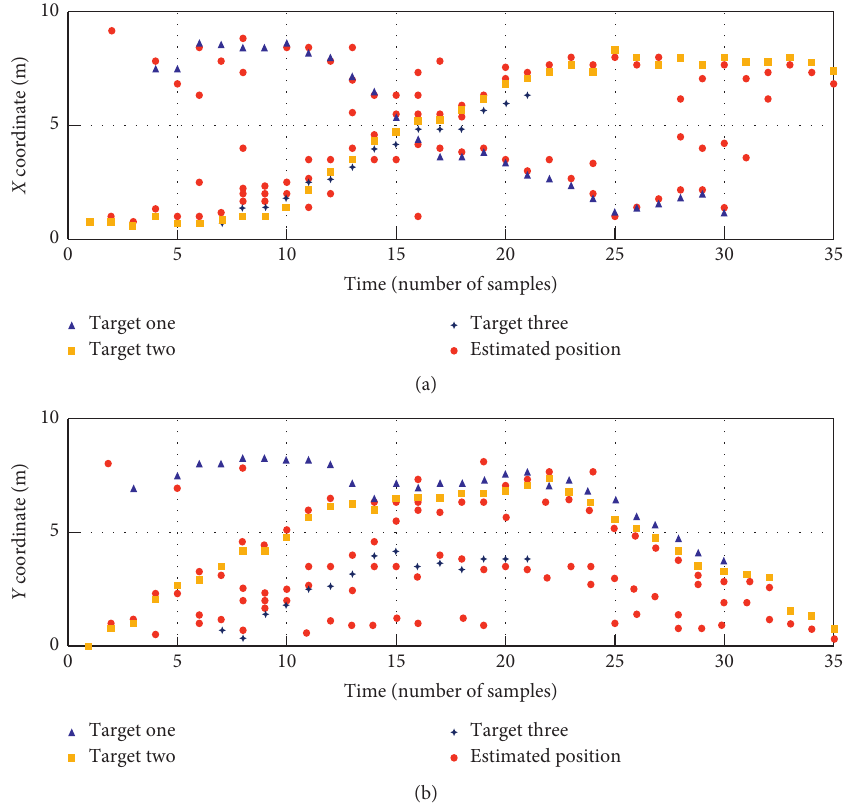
Figure 10: Coordinate sketch of moving target location results based the on deep learning